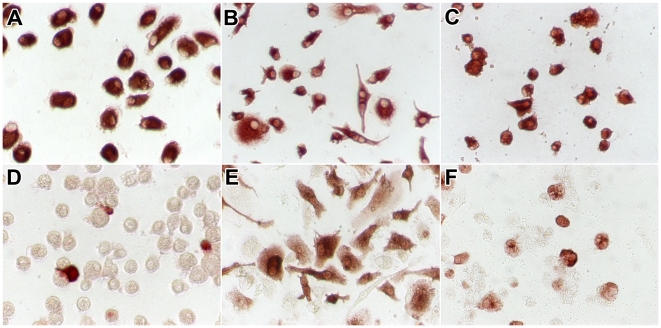
CD68 and influenza A virus antigen expression in alveolar macrophages and macrophages cultured from monocytes.Macrophages included were alveolar macrophages (a, d), macrophages cultured from monocytes in the presence of human serum (b, e), and macrophages cultured from monocytes in the presence of GM-CSF (c, f). In uninfected cells, staining for CD68 (a–c) confirms that these cells were of the monocyte/macrophage lineage. Twenty-four hours after infection with HPAIV H5N1, staining for influenza A virus nucleoprotein (d–f) confirms that these cells were infected by influenza virus.